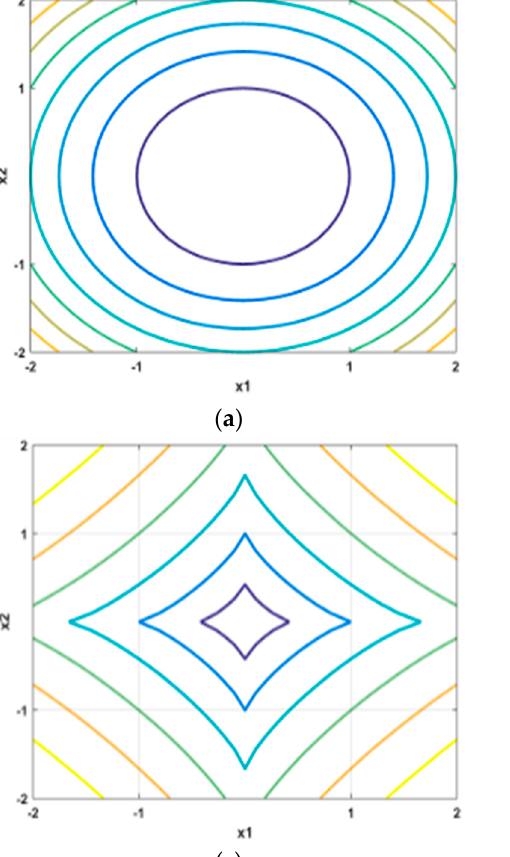
Figure 2. Feasible regions of